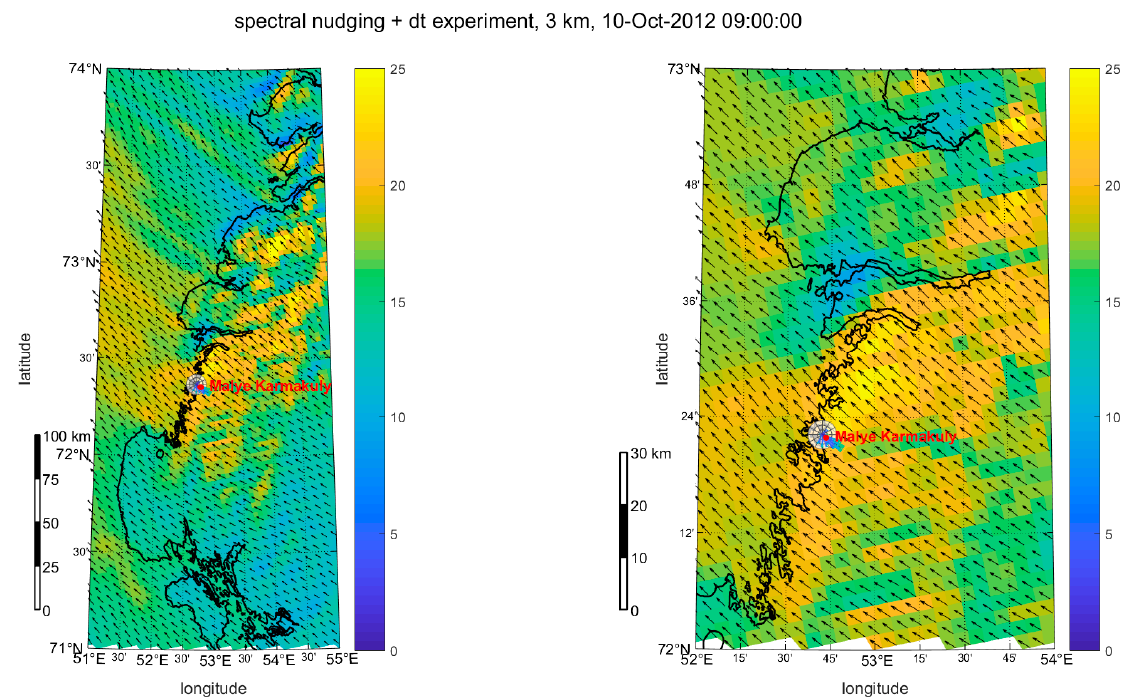
Figure 9. Wind speed (m/s) and direction at the Malye Karmakuly station region, on 10 October 2012, at 09:00 GMT for the ≈ 3 km experiment, *_sn_dt. Right panel is the enlarged version of the left panel.